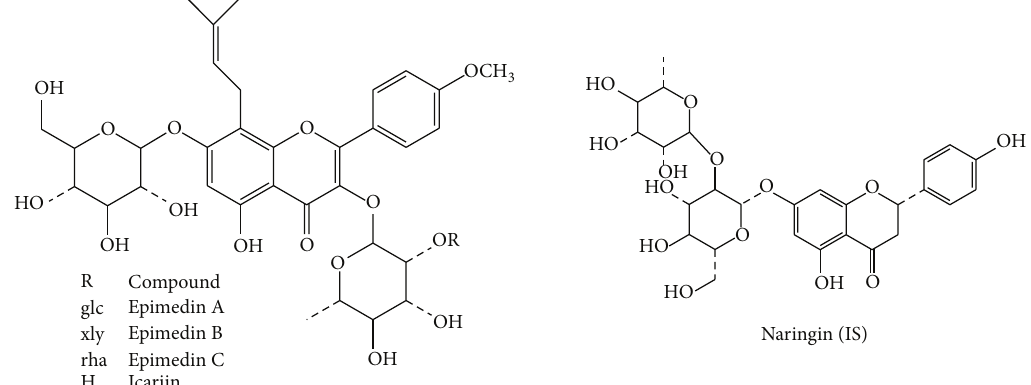
Figure 2: Chemical structure of epimedin A, epimedin B, epimedin C, icariin, and naringin